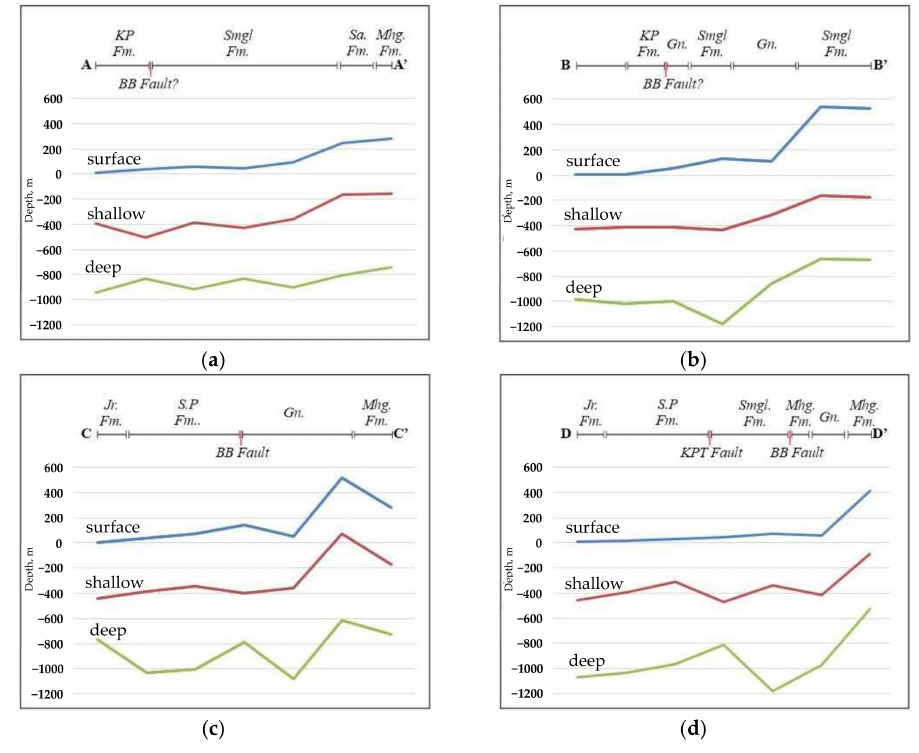
Figure 14. ( a ) Line A-A’; ( b ) Line B-B’; ( c ) Line C-C’; ( d ) Line